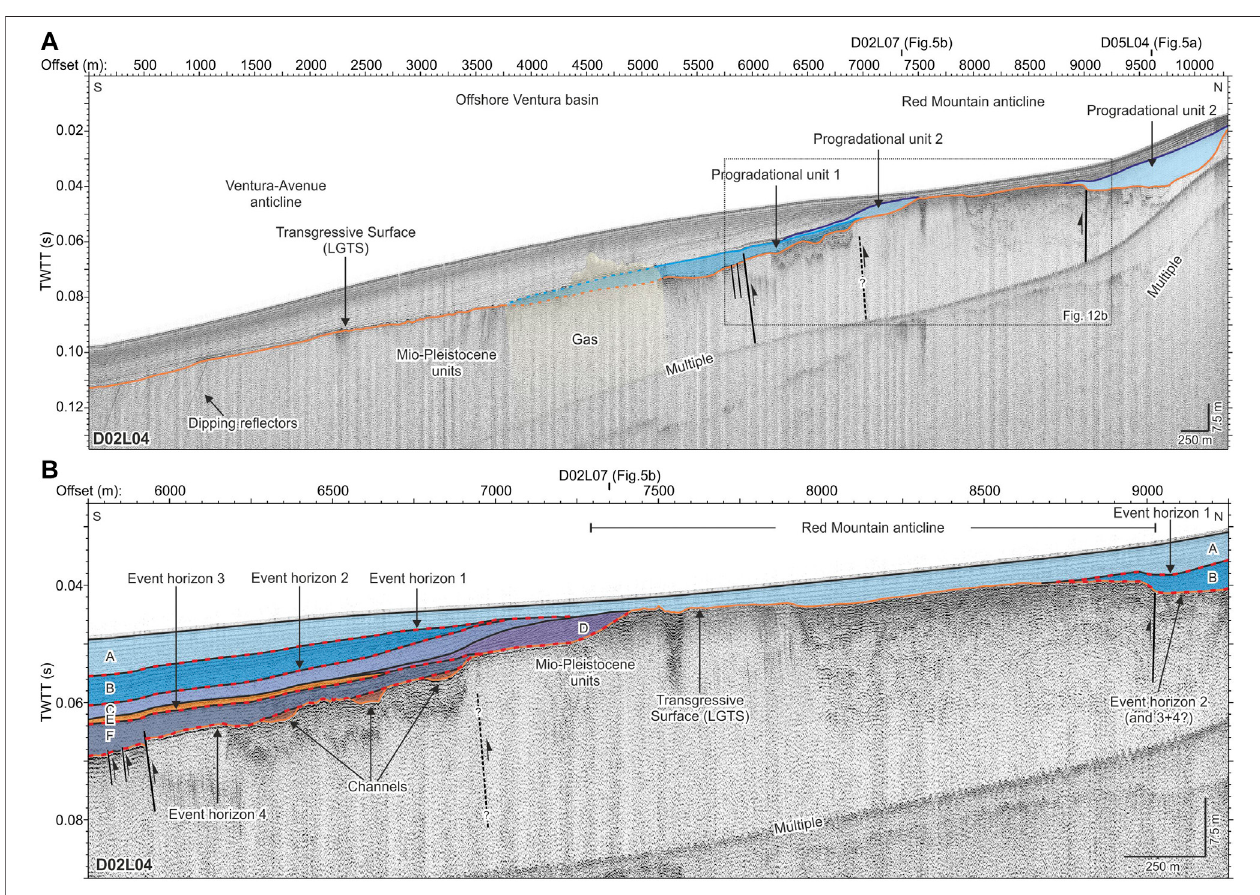
FIGURE 12 | (A) Interpreted CHIRP dip pro fi le D02L04 showing the folding of the Last Glacial transgressive surface (LGTS; continuous orange line) related to the offshoreRedMountainanticline.Thelightblueunitisboundedonthetopbybluelinescorrespondingtodifferentprogradationalunitsidenti fi edinthearea.Thelocationof the pro fi le is shown in Figures 2 , 3 . (B) Enlargement location is shown by rectangle in Figure 12A , which shows the uplift and deformation of the LGTS (orange continuous line). Different seismostratigraphic units (A – F) based on stratal relations are identi fi ed. The red dashed lines identify horizons corresponding to different deformation events (i.e., Inferred earthquakes). Uninterpreted pro fi les are provided in Supplementary Figure S10 .